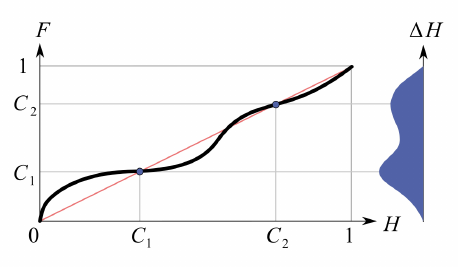
Figure 4. Generalization of the proposed hue modification function: regions with small slope provide histogram compression by the desired peaks C 1 and C 2 , while continuity of the function in regions with steep slope ensures continuity of the modified histogram. Here, Bezier spline was used for the illustration.